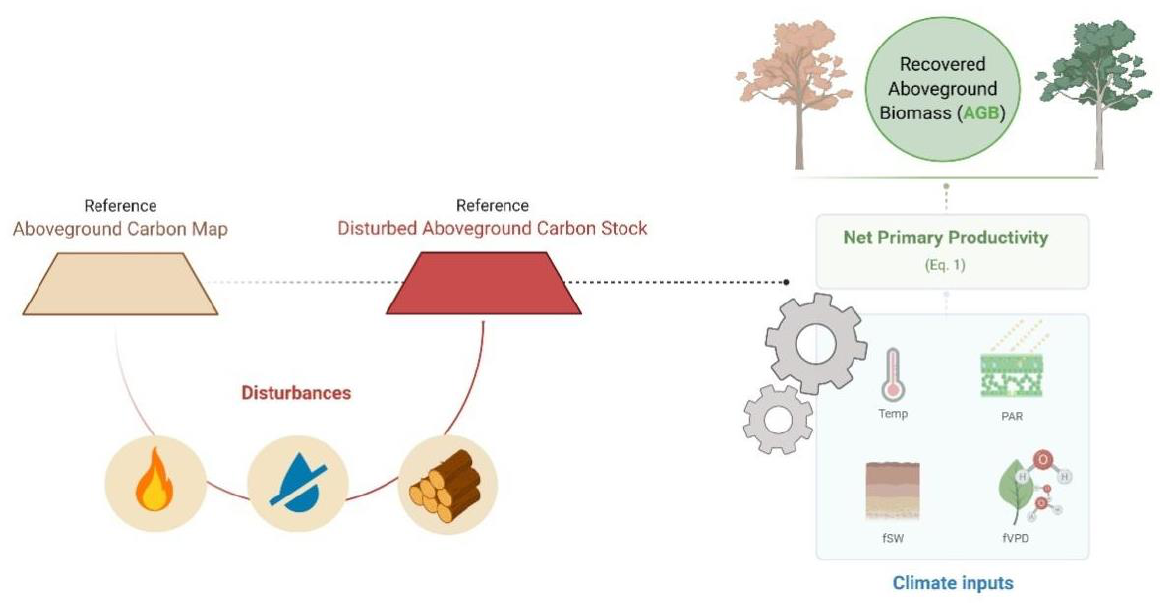
Figure 1. Proof–of–concept vegetation recovery time simulations as a function of climate variables (i.e., soil-plant available water ( fSW ), photosynthetically active radiation (PAR), vapor pressure deficit ( fVPD ), and air temperature ( fTemp ), see The Model for description). Aboveground biomass (AGB) losses resulting from drought stress and fire are a function of the maximum climatological water deficit (MCWD, see The Model for description).